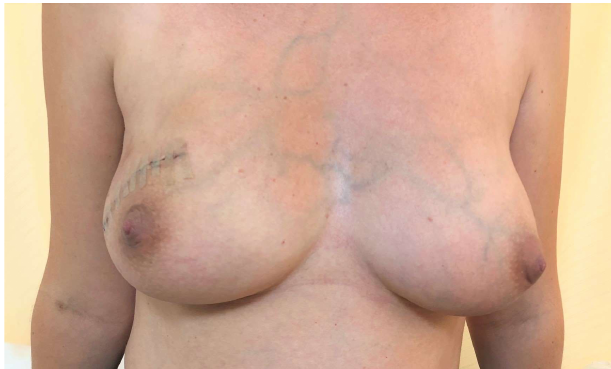
Figure 1. Early postoperative aspect after wide local excision of the tumor of the right breast.